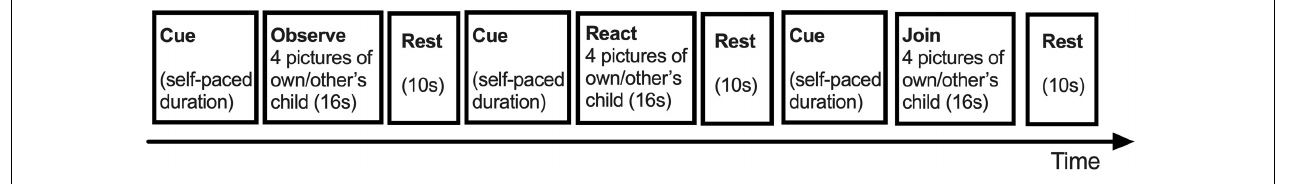
FIGURE 2 | The design of child face mirroring task [adapted from Ho et al. (2020)]. Note that the task order in this figure did not represent the actual